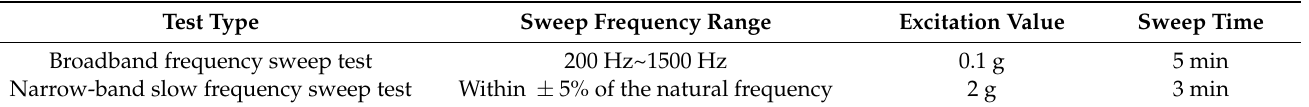
Table 1. Frequency sweep test conditions.